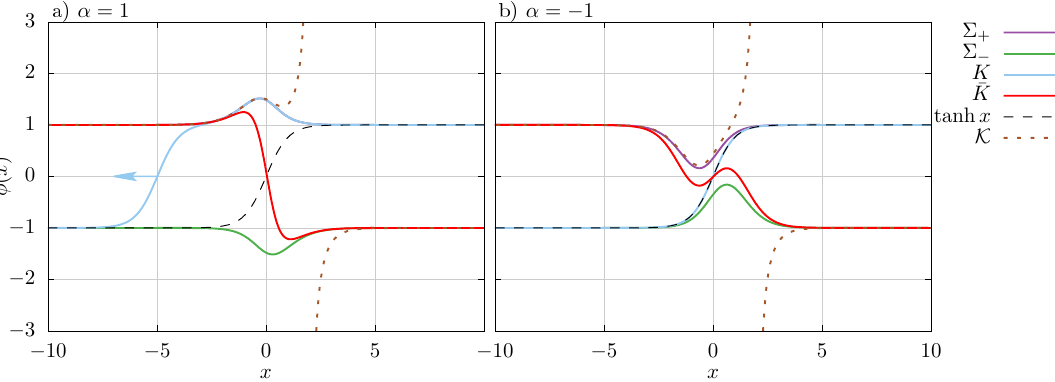
Figure 9 . Kink-impurity K , antikink-impurity (cid:22) K and topologically trivial lumps (cid:6) (cid:6) for the impurity model with (cid:11) = 1 (left) and (cid:11) = (cid:0) 1 (right). The dotted purple line corresponds to a static singular